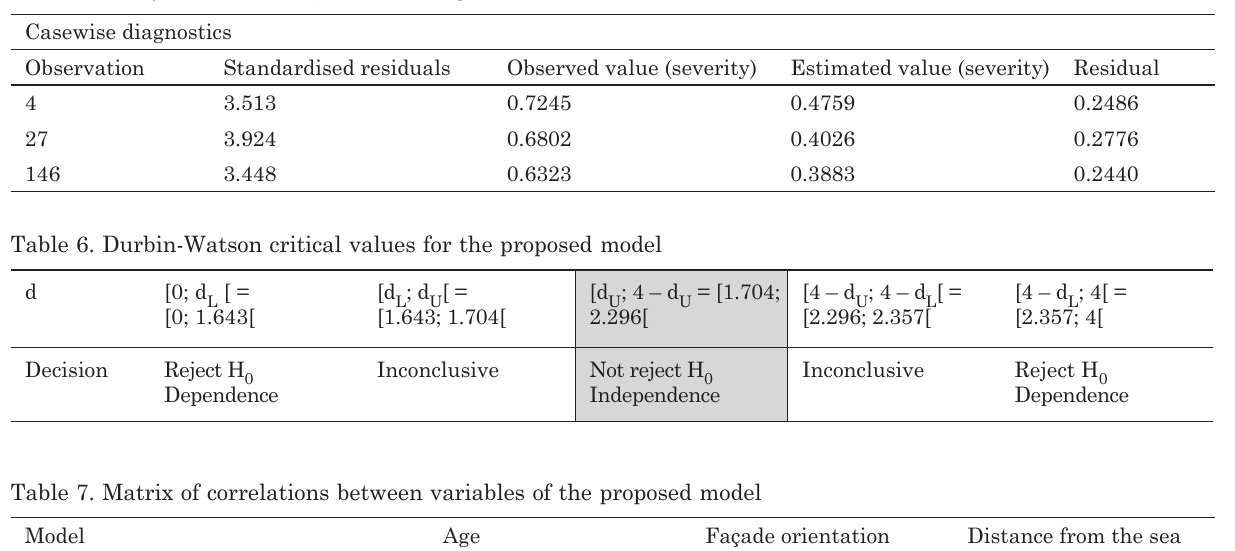
Table 7. Matrix of correlations between variables of the proposed model Model